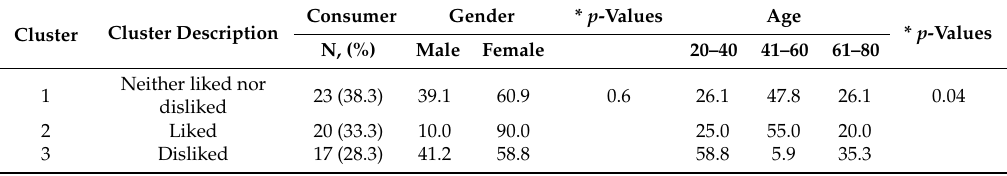
Table 6. Relationship between consumer segments, gender, and